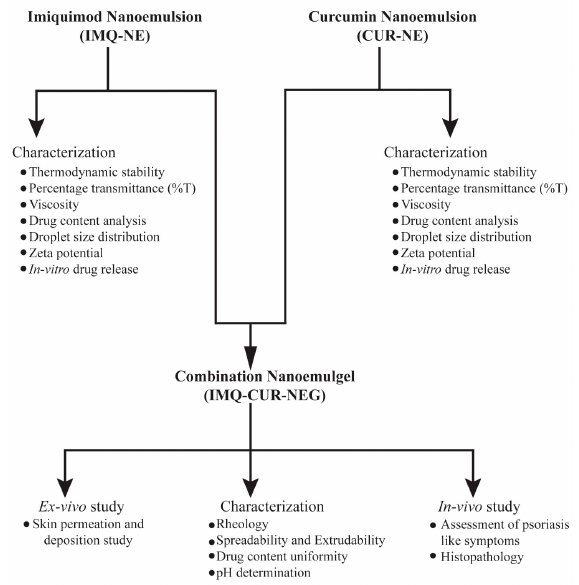
Figure 1. Schematic presentation of experimental methodology illustrating the development of the combination nanoemulgel containing imiquimod and curcumin.